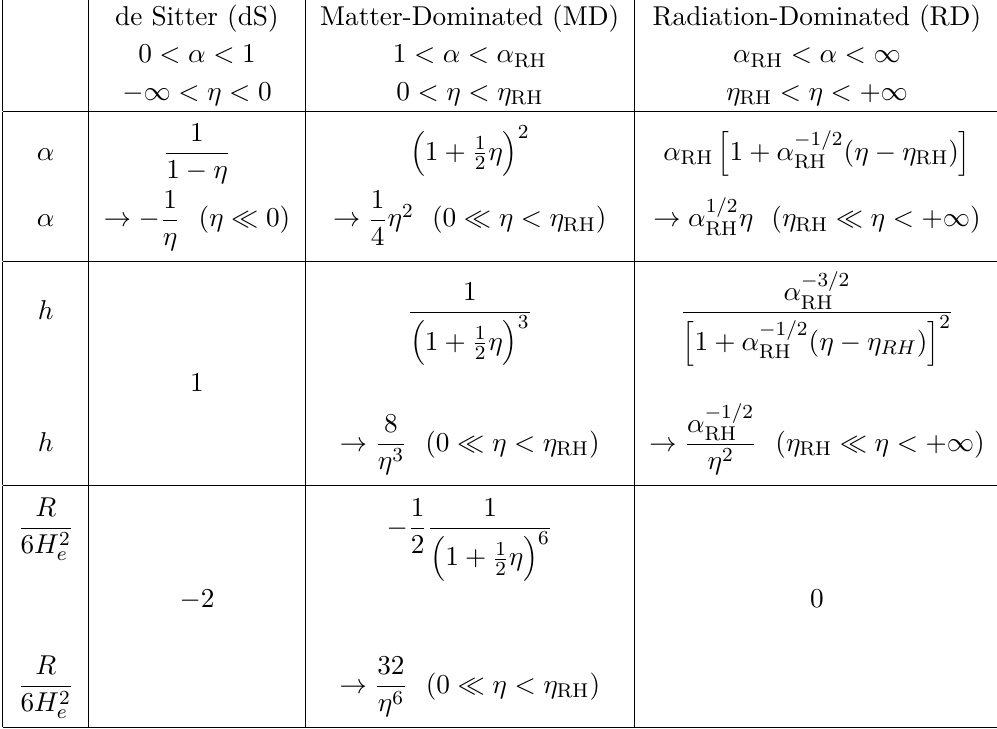
The dependence of the scale factor, the expansion rate, and the scalar curvature on conformal time η . We assume that the de Sitter era is followed by a matter-dominated era until reheating, which initiates a radiation-dominated era. Dimensionless variables are defined by eqs. (3.1) and